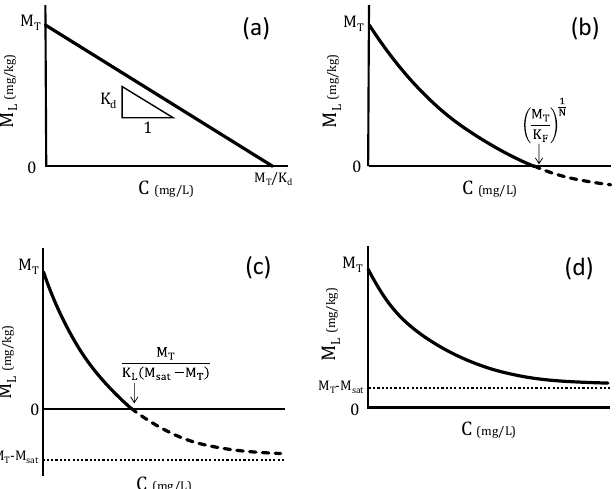
Figure 1. Schematic relationships between liquid phase concentration and eluted amount per mass in LS-parallel test. ( a ) Henry (linear) type, ( b ) Freundlich type, ( c ) Langmuir type of M T < M sat , and ( d ) Langmuir type of M T > M sat .